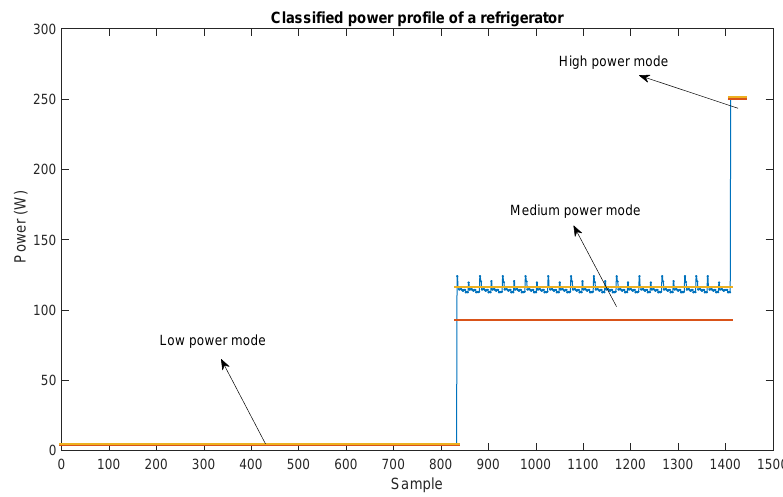
Figure 9. The classified power profile of a